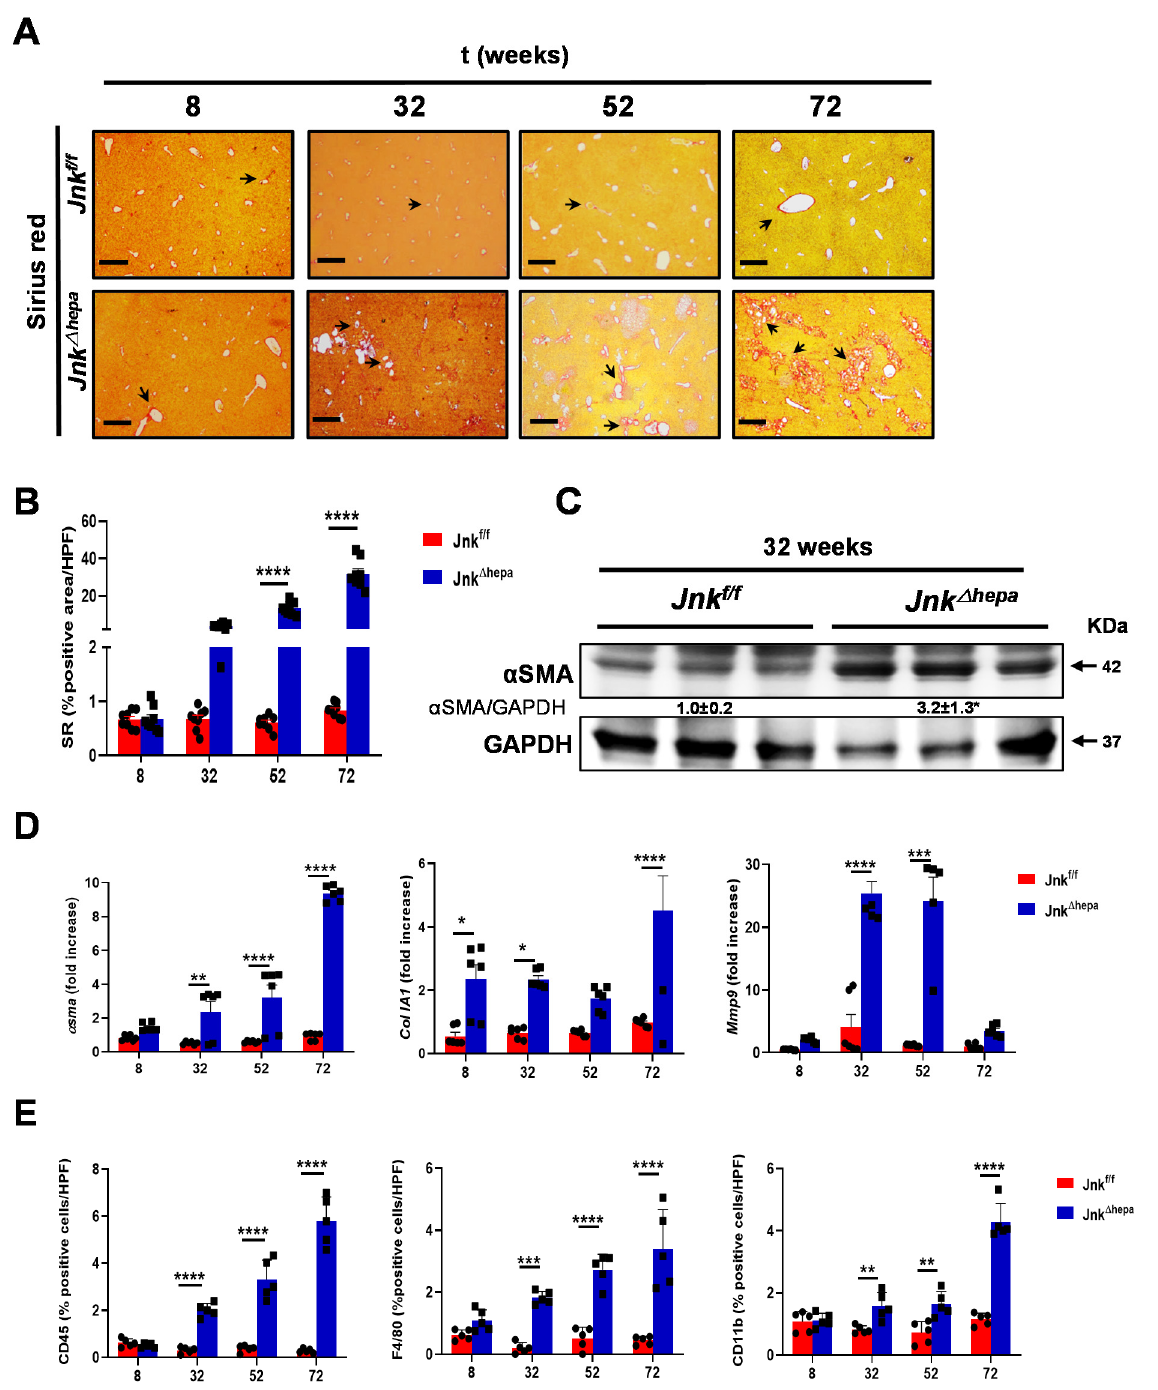
Figure 1. Fibropolycystic disease in aging Jnk ∆ hepa mice is characterized by extracellular matrix deposition and inflammation. ( A ) Fibrosis was evaluated by SR staining in 8- to 72-week-old Jnk f/f and Jnk Δ hepa mice. Scale bars, 500 µm. ( B ) Quantification of SR areas was performed using ImageJ. Protein and mRNA expression was analyzed for α Sm a ( left panel ), ColIA1 ( center panel ) and Mmp9 ( right panel ) using Western Blot ( C ) and qRT-PCR ( D ), respectively (* p < 0.05; intergroup significance). ( E ) Quantification of positive cells from IF microphotographs of CD45 ( left panel ), F4/80 ( center panel ) and CD11b ( right panel ) is shown in 8- to 72-week-old Jnk f/f and Jnk Δ hepa mice. Data are shown as the mean ± SEM and graphed, separately ( n = 6 mice per group) (* p < 0.05; ** p < 0.01; *** p < 0.001;**** p < 0.0001).